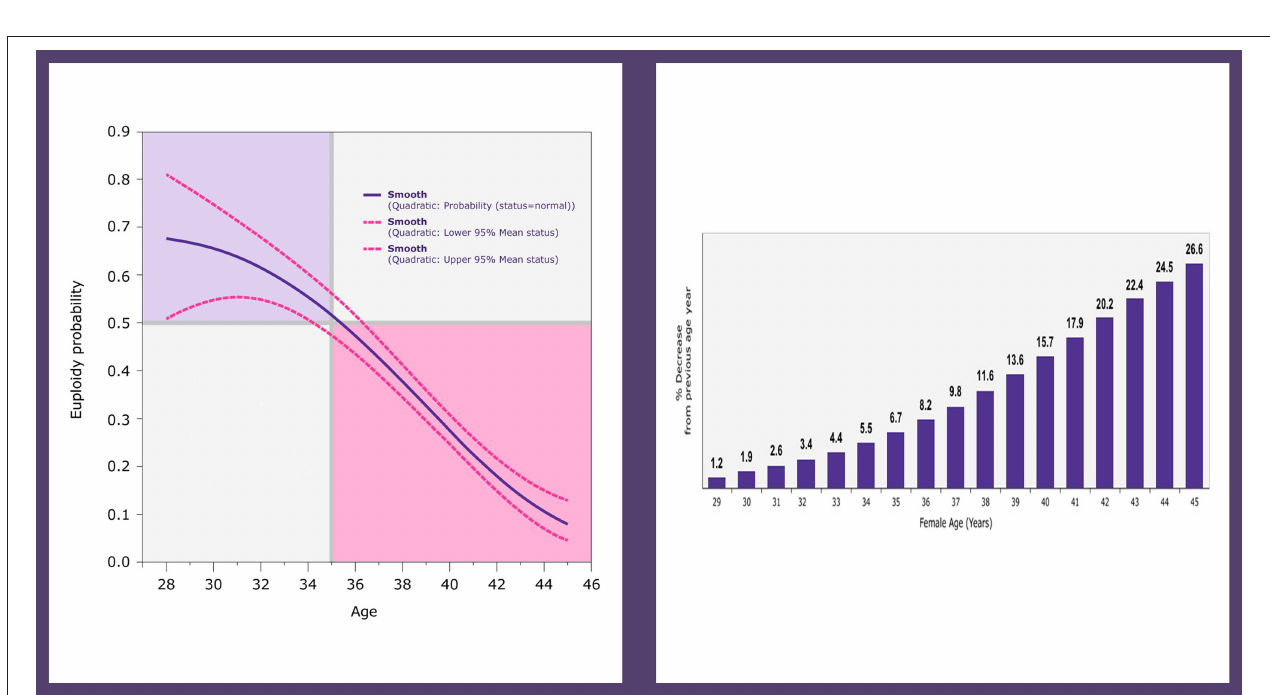
FIGURE 2 | Logistic regression analysis of 1,220 trophectoderm biopsies from 436 patients undergoing ICSI and PGT-A by NGS. The plot depicts the fitted probabilities (with 95% confidence intervals) of blastocyst euploidy as a function of female age (left) . The graph shows the percent decrease in the probability of a blastocyst being euploid, which increases progressively with every year of female age (right) . Reprinted with permission of Edizioni Minerva Medica from Esteves et al. (21).